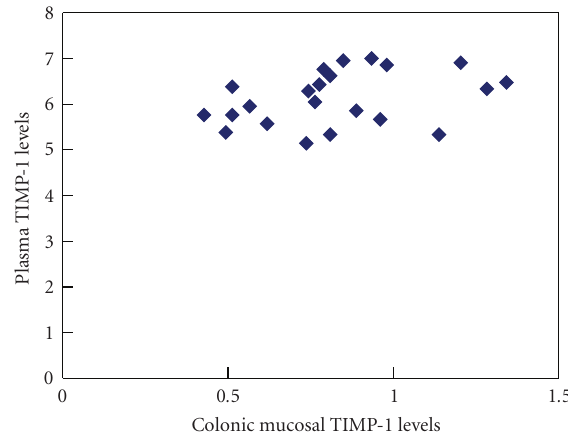
Figure 4: Correlation between plasma and mucosal TIMP-1